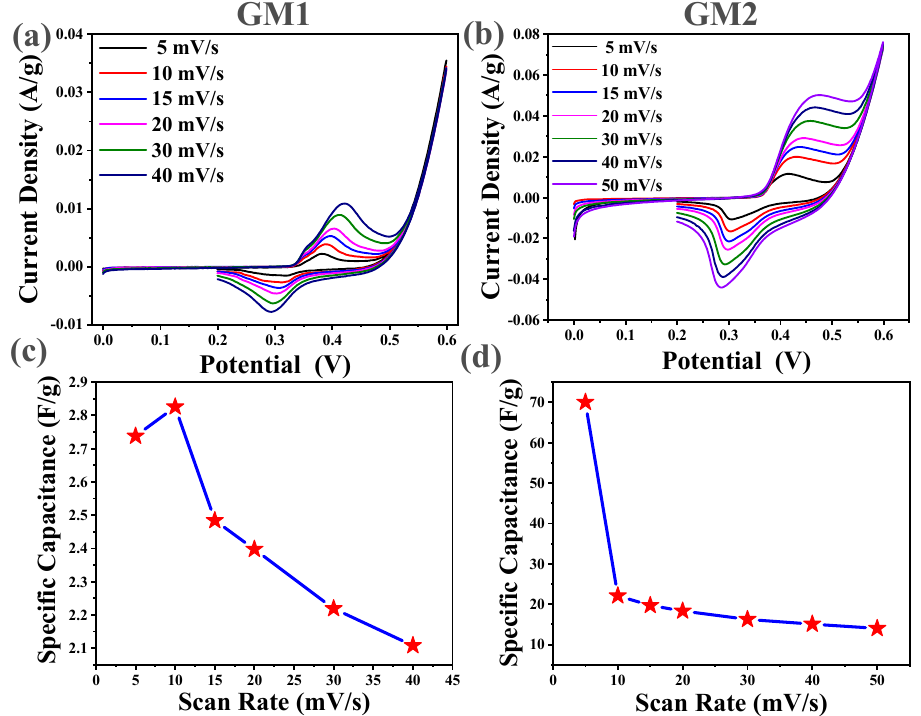
Figure 6. Cyclic-voltammetry curves of ( a ) GM1 and ( b ) GM2 at different scan rates in 6 M KOH; Csp. vs scan rate of ( c ) GM1 and ( d ) GM2.